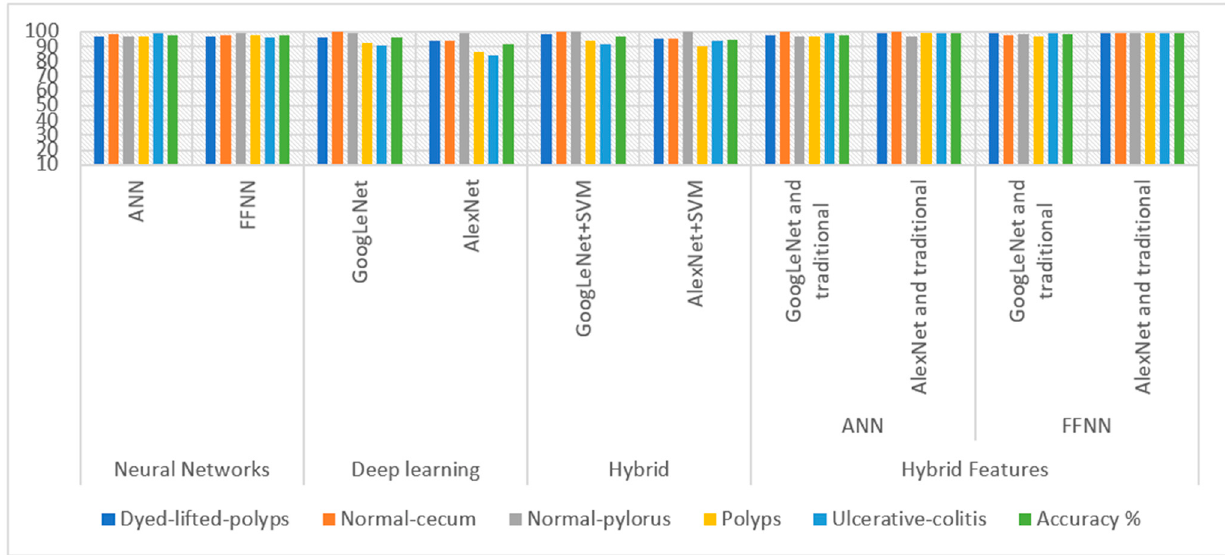
Figure 25. Display of results comparison of all the proposed methods for diagnosing a low GI da- taset.